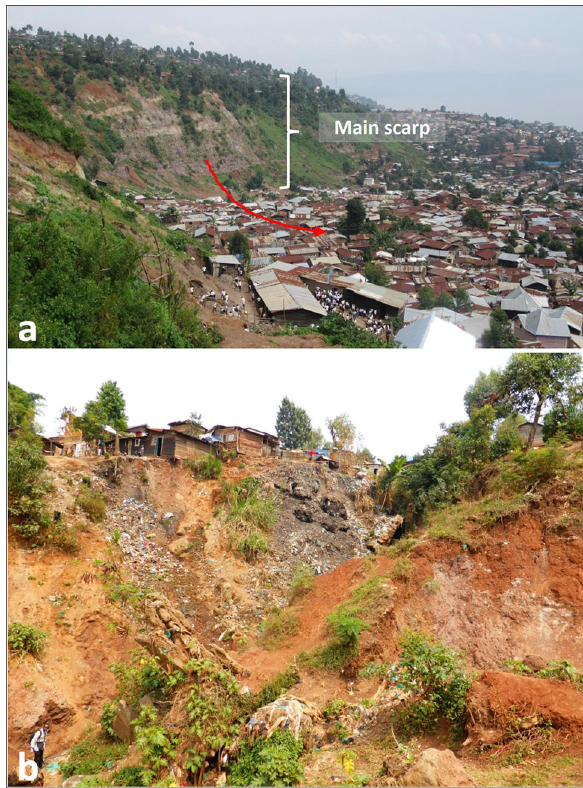
Fig. 7 a View of the largest landslide of Bukavu in the Funu neighborhood (Photograph taken by Olivier Dewitte, August 2015). b Example of a large active gully that develops in the landslide (Photograph taken by Olivier Dewitte, July 2014)